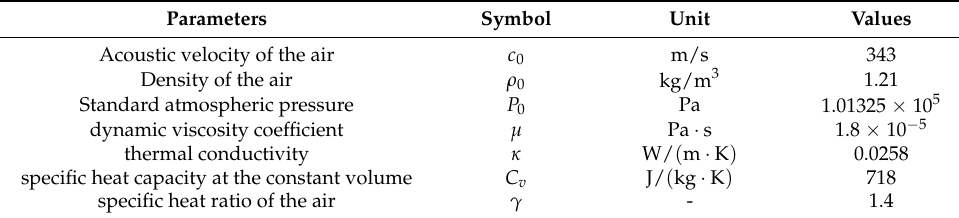
Table 1. Summary of the utilized constants in the theoretical model for the